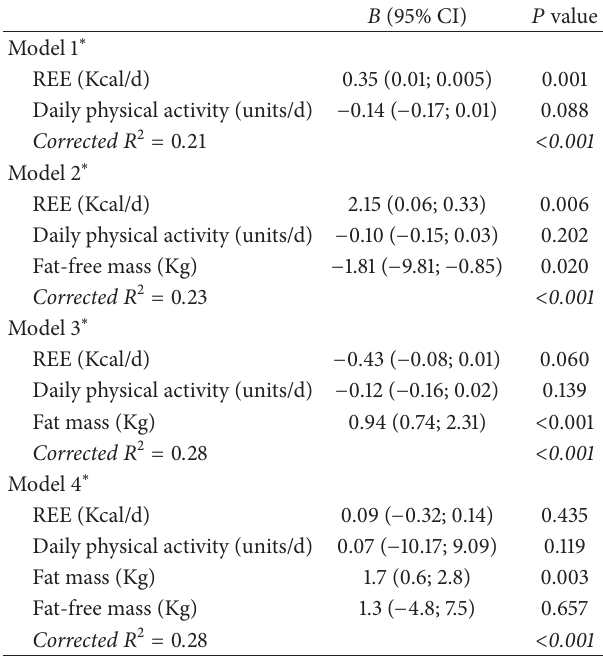
Table 1: Independent effects of body composition and activity markers on variations in irisin plasma